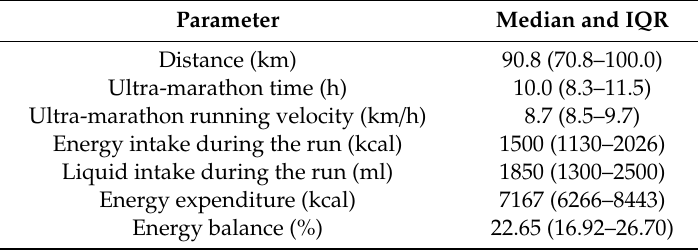
Table 2. Ultra-marathon 100 km race performance